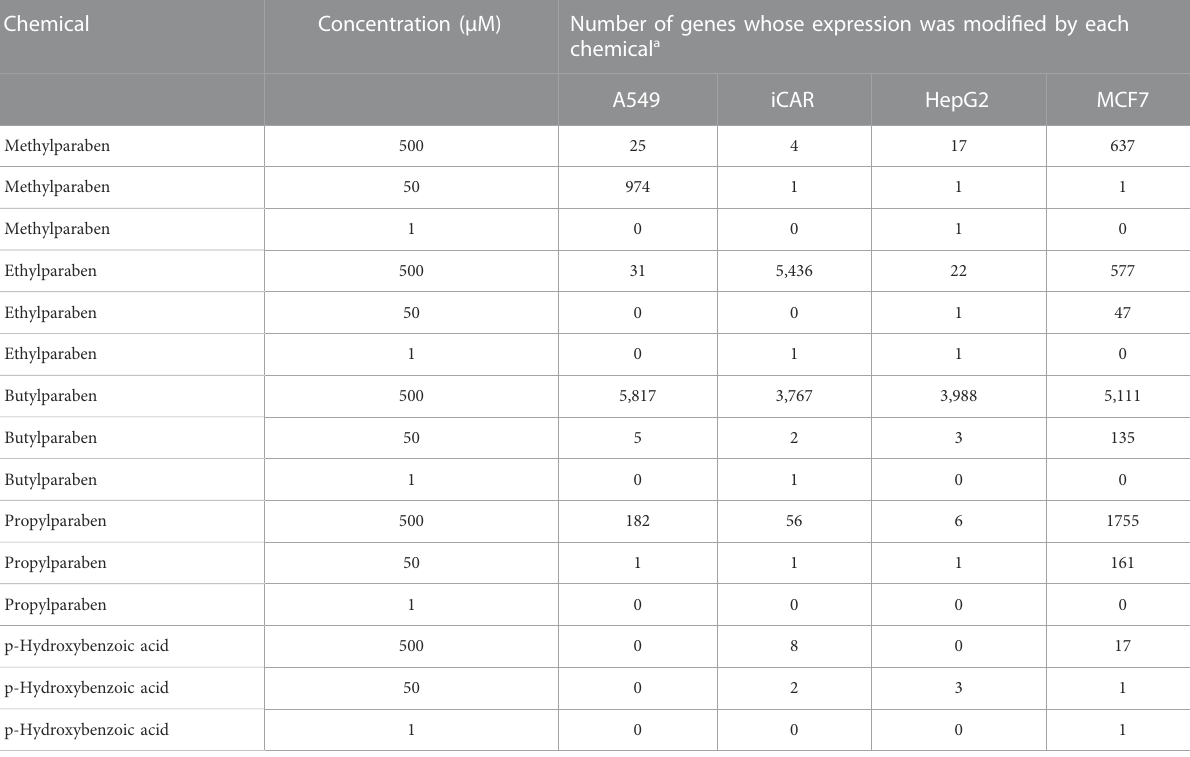
TABLE 1 Number of genes whose expression was signi fi cantly (FDR < 0.05, FC ± 1.2) modi fi ed by MP (CAS# 99 – 76-3), EP (CAS# 120 – 47-8), BP (CAS# 94 – 26-8) and PP (CAS# 94-13-3), as well as the main metabolite of these parabens, pHBA (CAS# 99-96-7), in each of the cell types